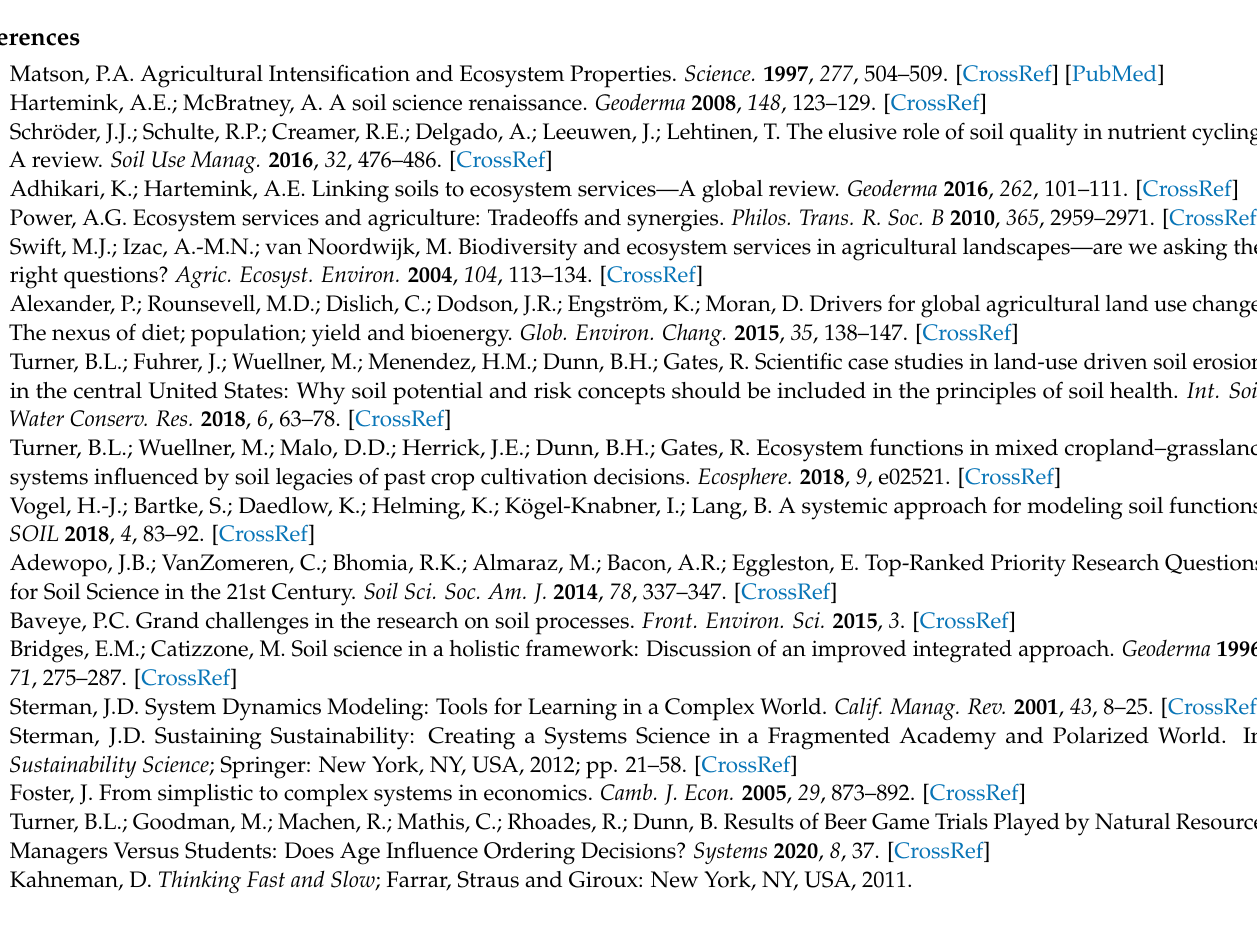
Figure A2. Supplementary biogeochemical results from the tillage test switch from conventional to no-tillage over 10 years (3650 days): (panel a ) salt concentration in soil water under conventional tillage (black) and no-tillage (gray) methods; (panel b ) soil salt level over 10 years under conventional tillage (solid) and no-tillage (dashed line) methods; (panel c ) irrigation efficiency under conventional tillage (solid) and no-tillage (dashed line) methods.